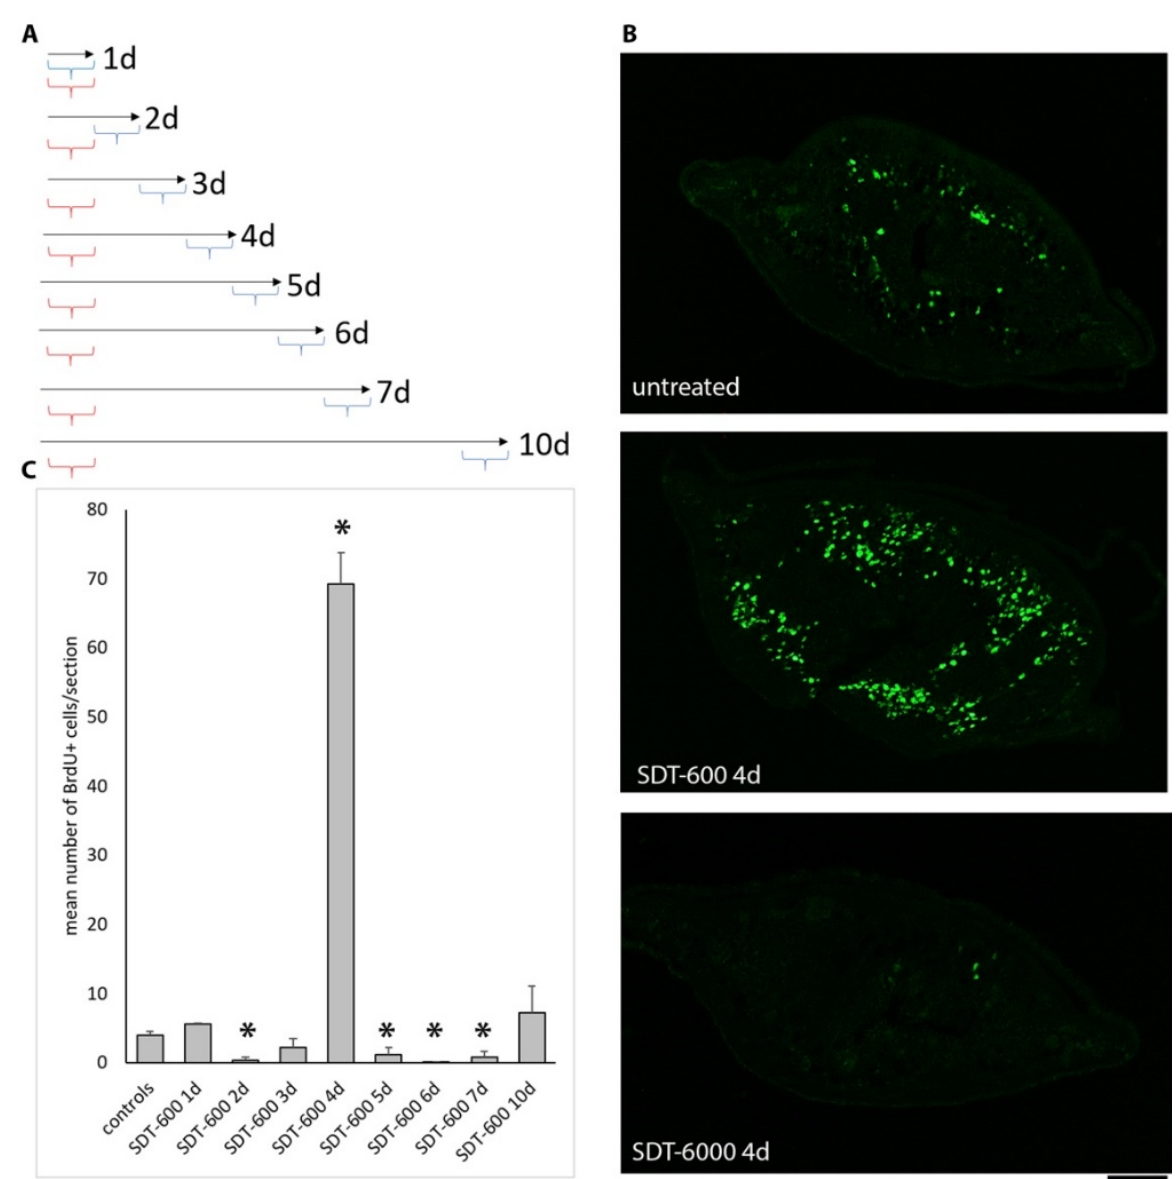
Figure 4. Analysis of BrdU incorporation. ( A ) Graph depicting the experimental setup. Red brackets indicate 5FU treatment, and blue brackets indicate the BrdU labeling time lapse. ( B ) Representative images of BrdU immunostaining on sections. ( C ) Histogram depicting the mean number of BrdU-positive cells counted during the first 10 days of treatment according to the experimental setup depicted in ( A ). Each bar is the mean value ± SD from five independent animals. Asterisks indicate a statistically significant difference (* p < 0.01) evaluated by the non-parametric, two-tailed Mann–Whitney U -test with respect to untreated controls. Scale bar corresponds to 125 μm.